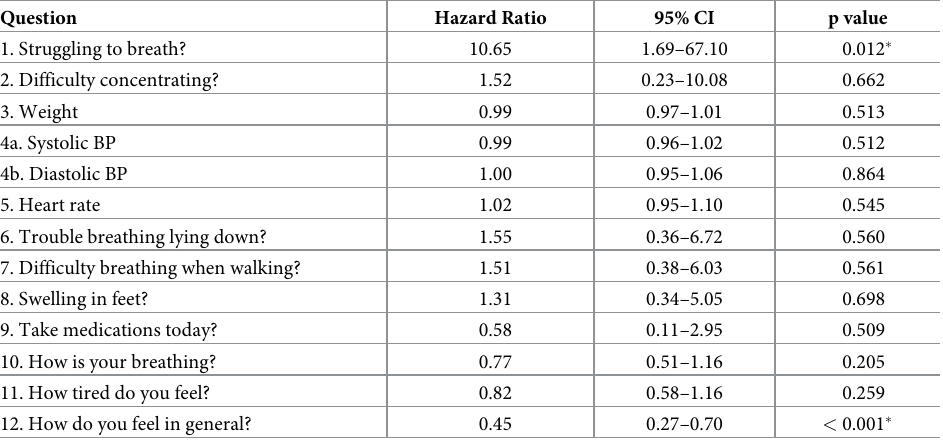
Table 3. Joint longitudinal and readmission models for patient-reported